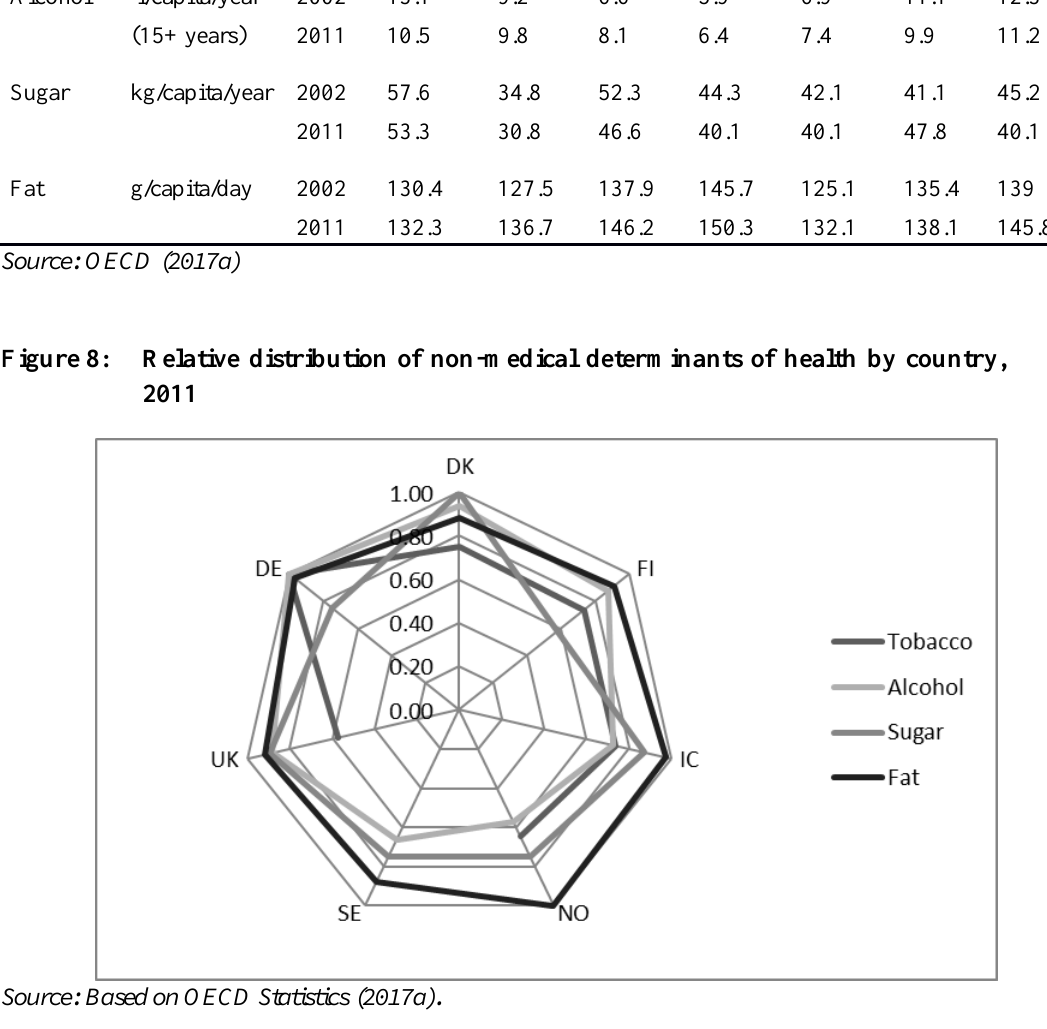
Source: Based on OECD Statistics